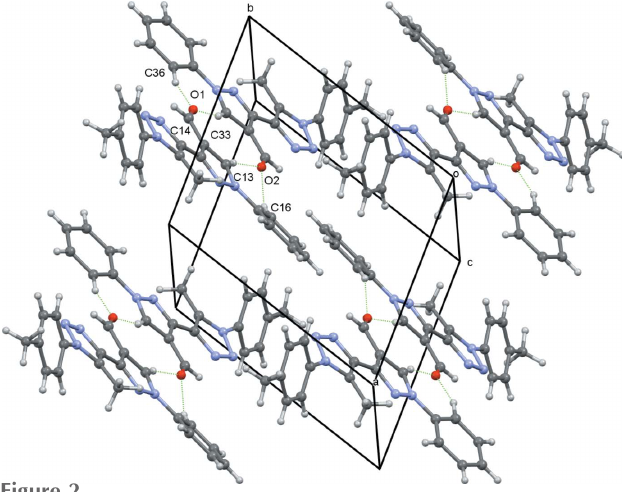
Figure 2 A view of the crystal structure along [001] showing intermolecular contacts as dotted lines.